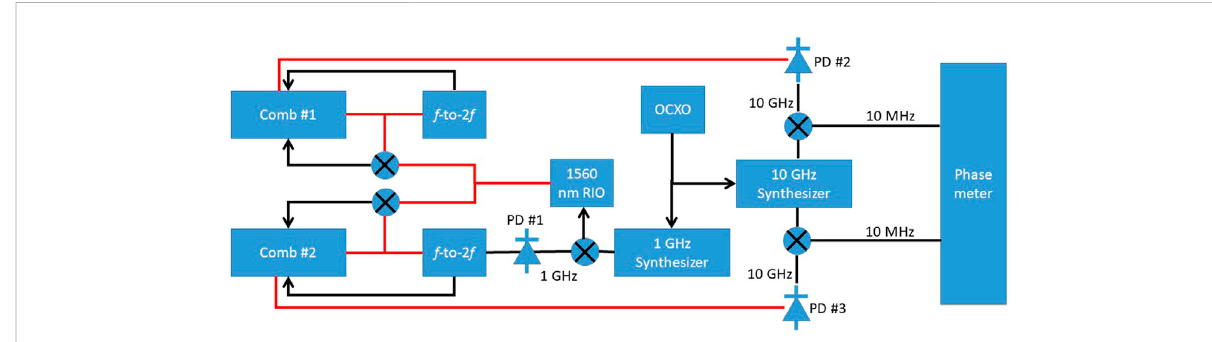
Correlation based phase noise measurement system for evaluation of frequency transfer from the optical to microwave domain. Here two